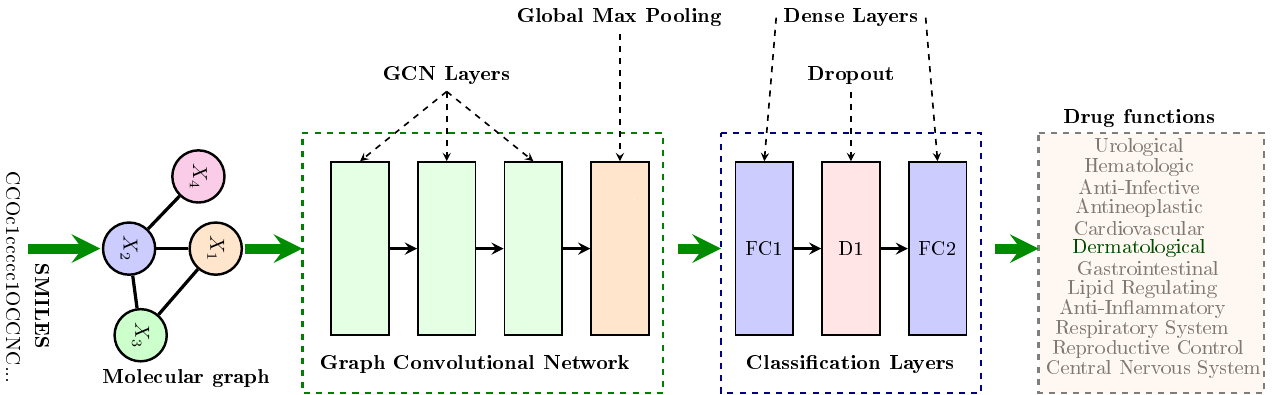
Figure 2. This figure depicts the architecture of the model used. The SMILES string representing each molecule is converted into a molecular graph. Then the graph convolution network learns a graph-based embedding for that molecule. This is then passed to the subsequent fully connected (dense) layers for classification. FC2 has 3, 5, or 12 outputs commensurate with the classification task.